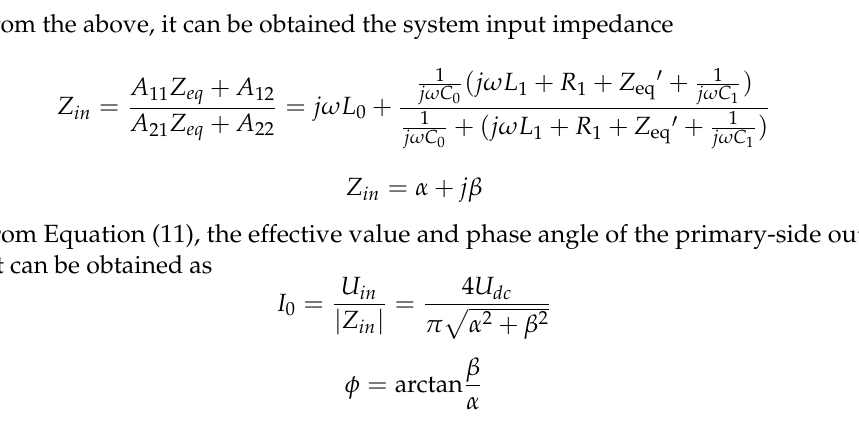
Table 1. WPT system simulation and experimental parameters.